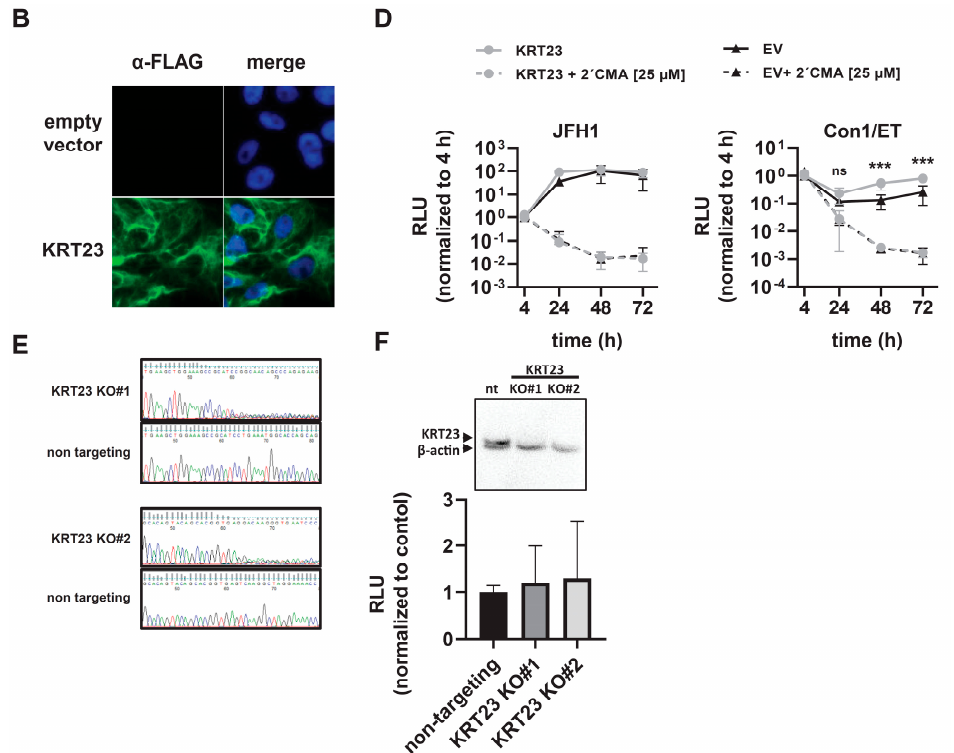
Figure 4. Expression of Keratin 23 facilitates HCV life cycle progression. ( A ) Western blot of Huh-7.5 cells stably expressing an empty vector (empty vector Huh-7.5) or 3xFLAG-KRT23 (KRT23 Huh-7.5). ( B ) Subcellular localization of KRT23 in KRT23 expressing Huh-7.5 cells. Cells were stained for 3xFLAG-tagged KRT23 (green), and nuclear DNA was stained with DAPI (blue). ( C ) Infection levels in empty vector and KRT23-expressing Huh-7.5 cells upon infection with HCV reporter virus JcR2a. Cells were infected with HCV JcR2a, and replication levels were determined by Renilla luciferase activity assay 24 h and 48 h post-infection. ( D ) HCV RNA replication e ffi ciency of subgenomic replicons JFH1 NS3-3 (cid:48) and Con1 / ET in empty vector and KRT23 Huh-7.5 cells. The firefly luciferase activity assay was performed to determine HCV RNA replication at the indicated time points. (C,D) Depicted are mean values ± standard deviation from three independent experiments (one-way ANOVA adjusted with Dunnett’s multiple comparison test; * p < 0.05; *** p < 0.001; ns: non-significant). ( E ) Editing of the target sequences in the designated KO cell lines. For validation, genomic DNA was sequenced to validate the loss of the consensus sequence in KO cell lines, compared with the non-targeting control. ( F ) Western blot of KRT23 KO Huh-7.5 cells and infection levels in non-targeting and KRT23 KO Huh-7.5 cells upon infection with HCV reporter virus JcR2a. Cells were infected with HCV JcR2a, and replication levels were determined by Renilla luciferase activity assay 48 h post-infection. (C,D,F) Depicted are mean values ± standard deviation from three independent experiments (one-way ANOVA adjusted with Dunnett’s multiple comparison test; * p < 0.05; *** p < 0.001; ns: